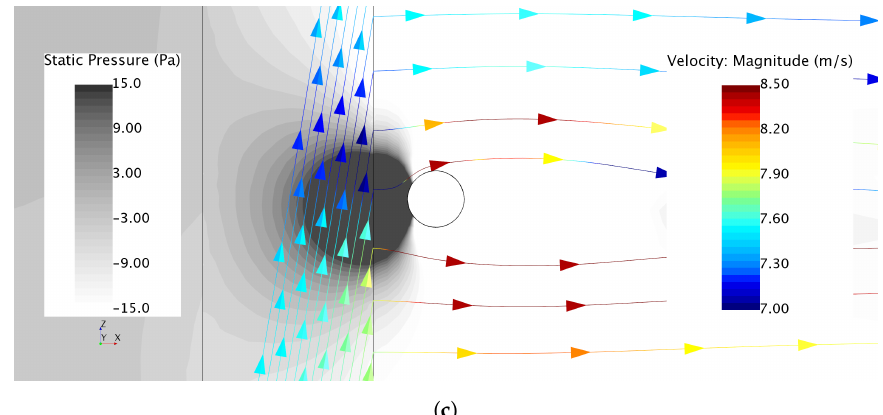
Figure 10. Longitudinal view of the static pressure field and streamlines of the relative velocity coloured by magnitude, for case F2 (downstream cylinder) without fan blades. ( a ) left hand, ( b ) centre and ( c ) right hand plane (compare Figure 9). ( a ) y = 0.15m; ( b ) y = 0m; ( c ) y = − 0.15m.